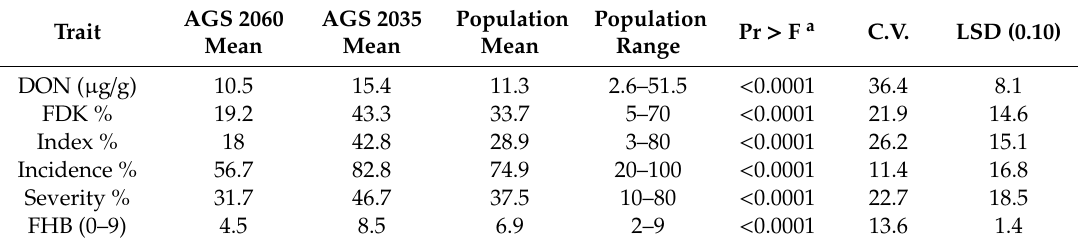
Table 2. Descriptive statistics for FHB resistance ratings of AGS 2060 x AGS 2035 DH population at Baton Rouge